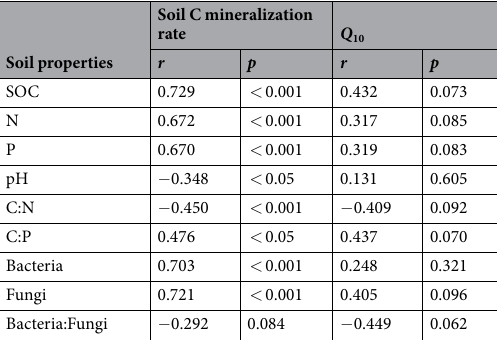
Table 3. Pearson correlations between soil properties and C decomposition rates and Q 10